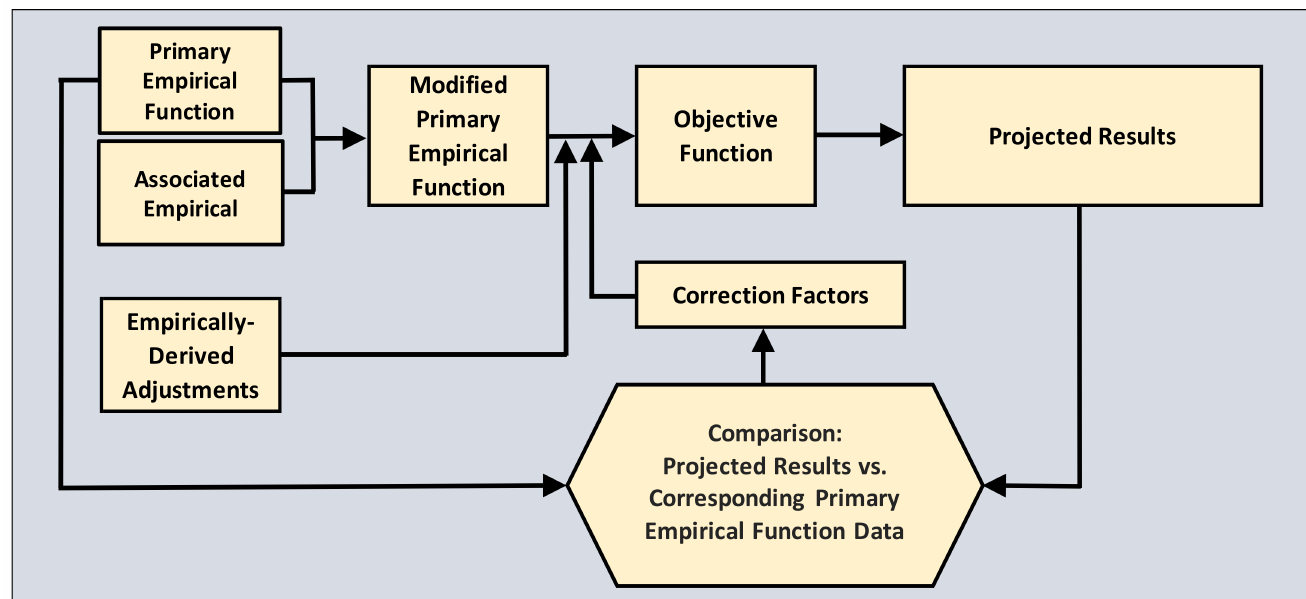
Figure 5. Methodology for combining an empirically derived primary function with an empirically derived associated function (future work item 1), plus optional recursive loop for successive corrections (future work item